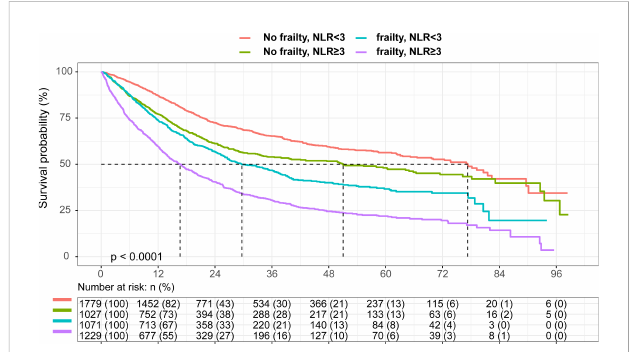
FIGURE 1 Kaplan-Meier curve According to Neutrophil to Lymphocyte Ratio and Frailty Present in Elderly Patients with